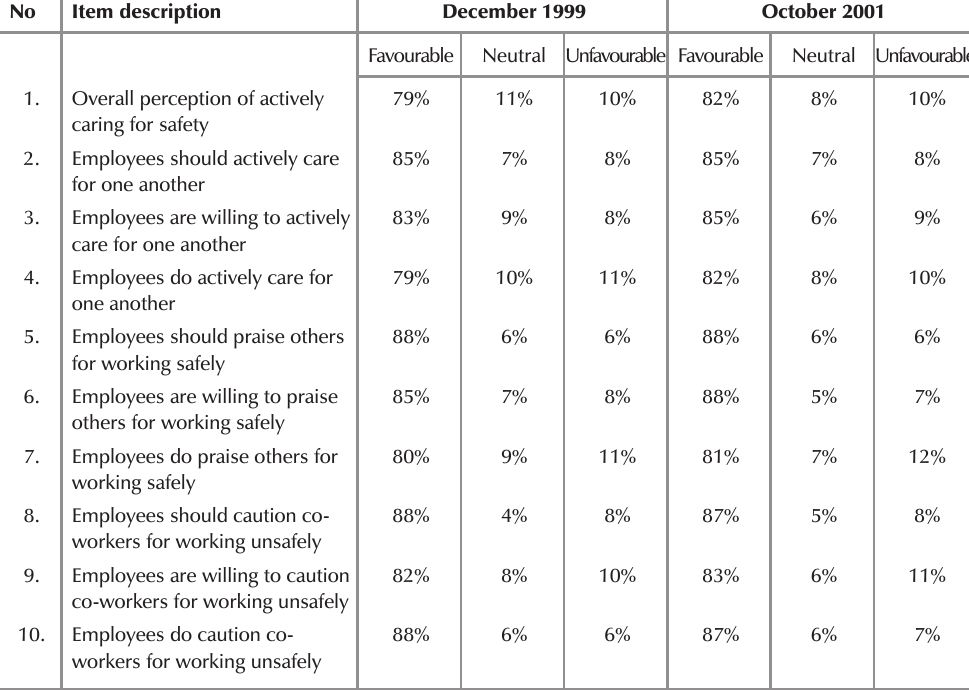
Outcome of culture survey with regard to the perception of actively